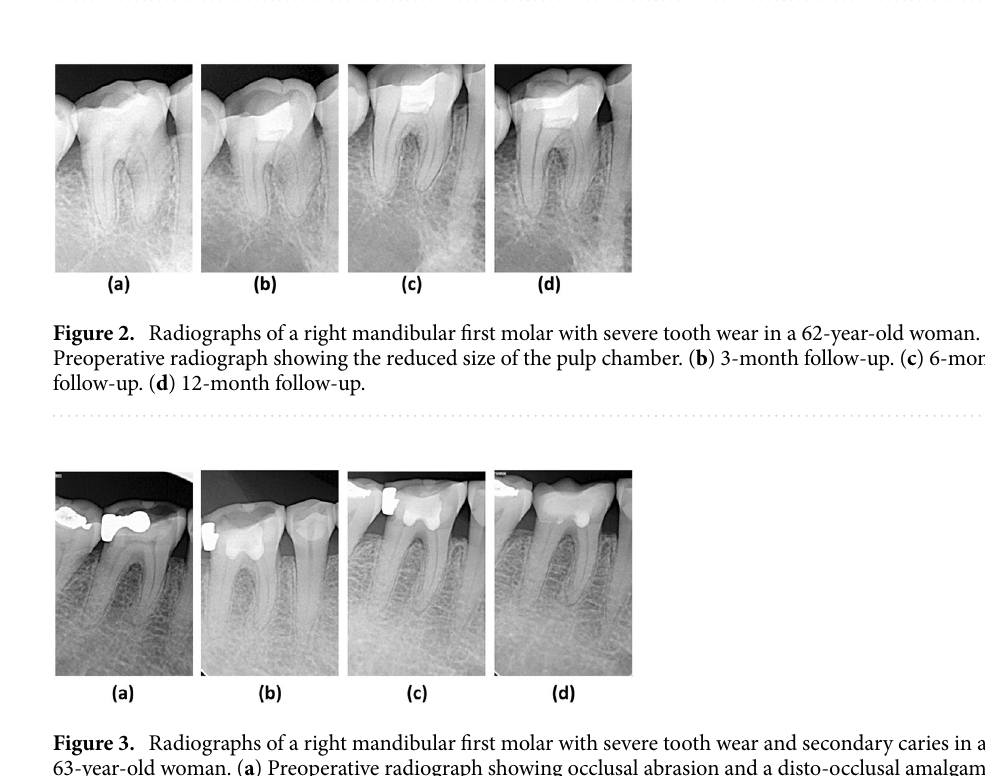
Table 3. Outcomes of pulpotomy according to different characteristics of the study participants. a Fisher’s exact test was used to determine associations between categorical variables.